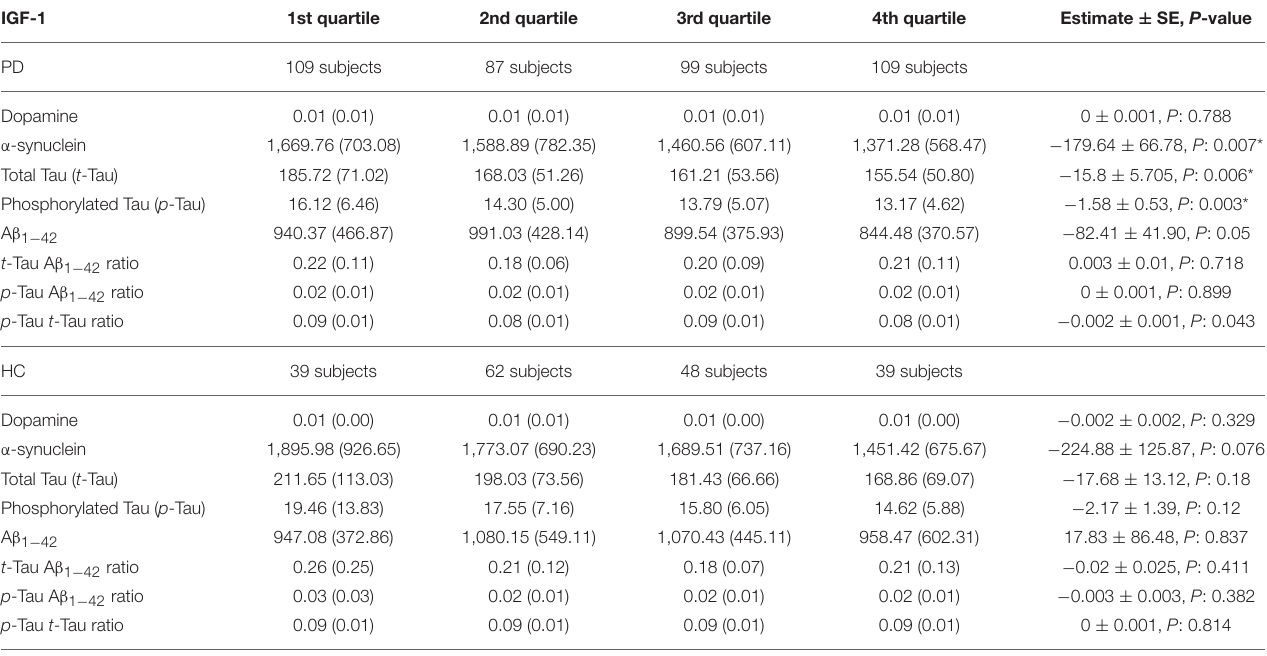
TABLE 2 | Association of CSF biomarkers with IGF-1 quartiles in PD and HC subjects. IGF-1